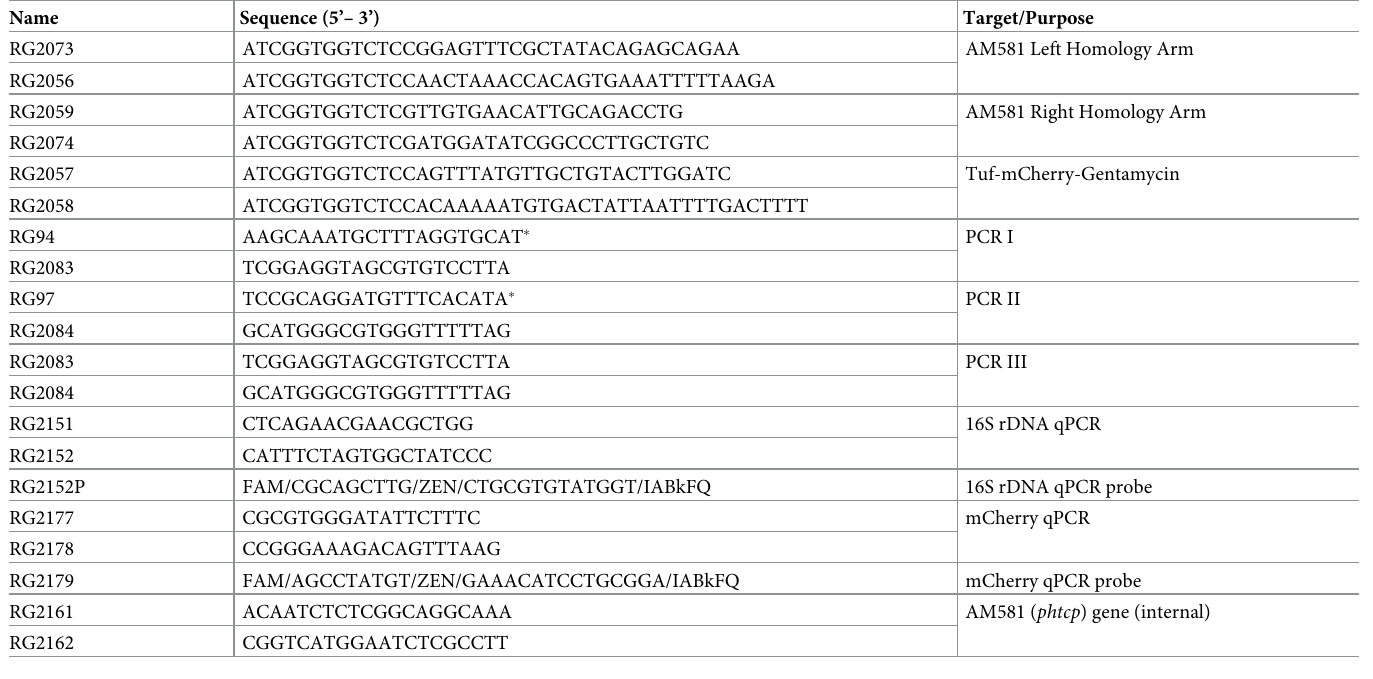
Table 3. List of oligonucleotides used in this